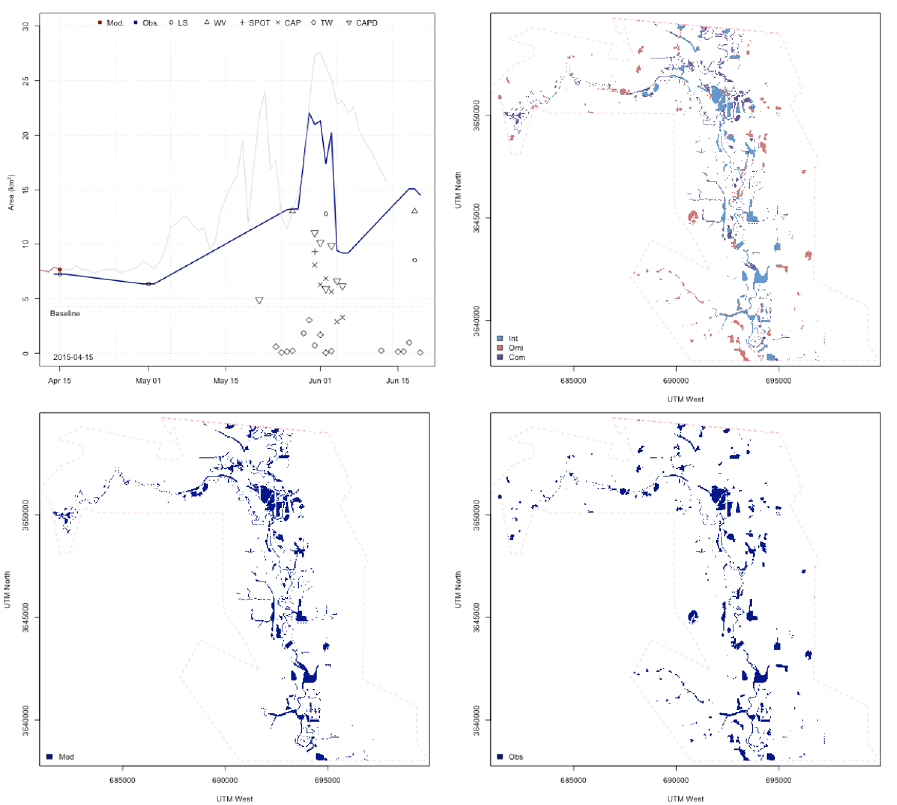
Figure 10. Flood inundation for 15 April 2015 estimated by MOP and HEC-RAS.